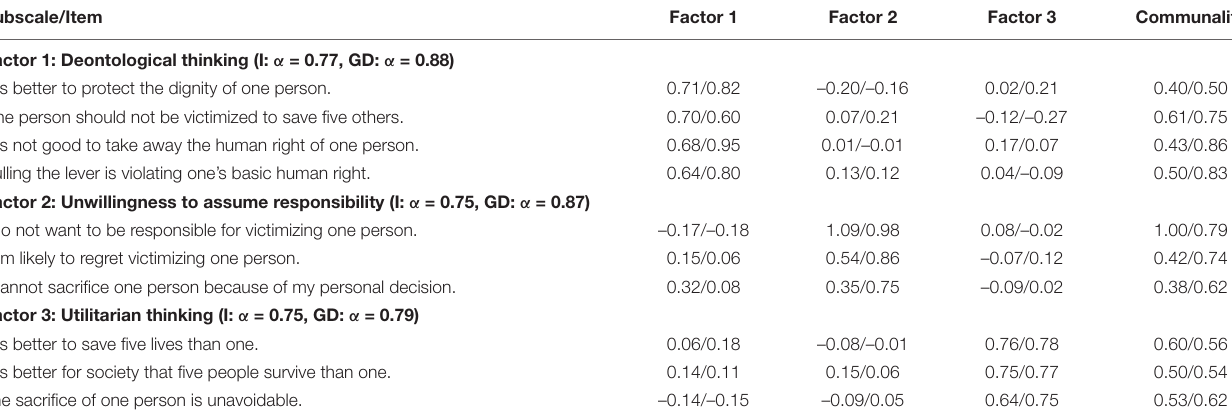
TABLE 1 | Factor loadings of the subscales of the thinking scale regarding the trolley dilemma issues. Subscale/Item Factor 1